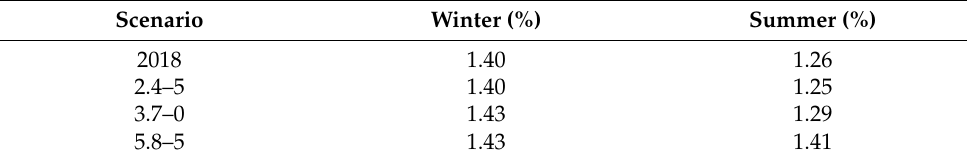
Table 4. Comparison of the % of groundwater in the first meter from the surface.